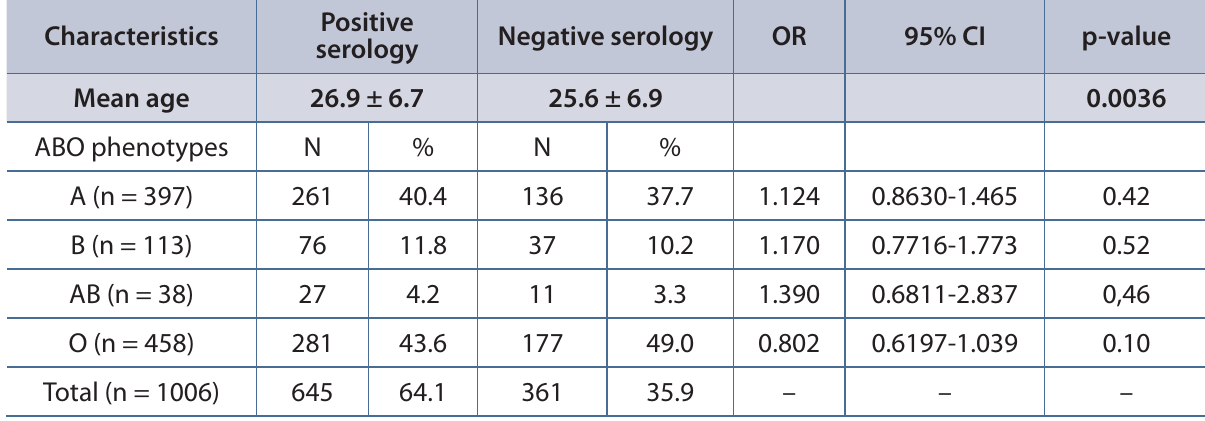
Table 1. Mean ages and frequencies of the ABO blood group phenotypes in pregnant women with positive and negative serology for IgG and IgM anti- Toxoplasma gondii antibodies, in São José do Rio Preto, Brazil